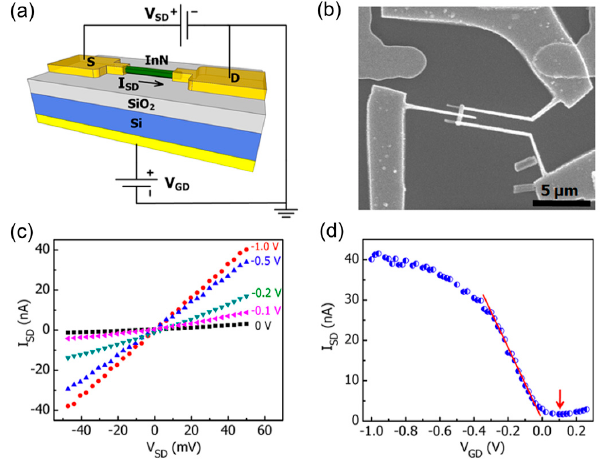
Figure 5. ( a ) Schematic of Mg-doped InN nanowire back-gate field-effect transistor; ( b ) The corresponding SEM image. A 3rd electrode is used to estimate the contact resistance; ( c ) I SD vs. V SD under different V GD ; ( d ) Transfer characteristics measured at V SD = 0.05 V. The line is a linear fit. The arrow marks the conduction minimum [43].